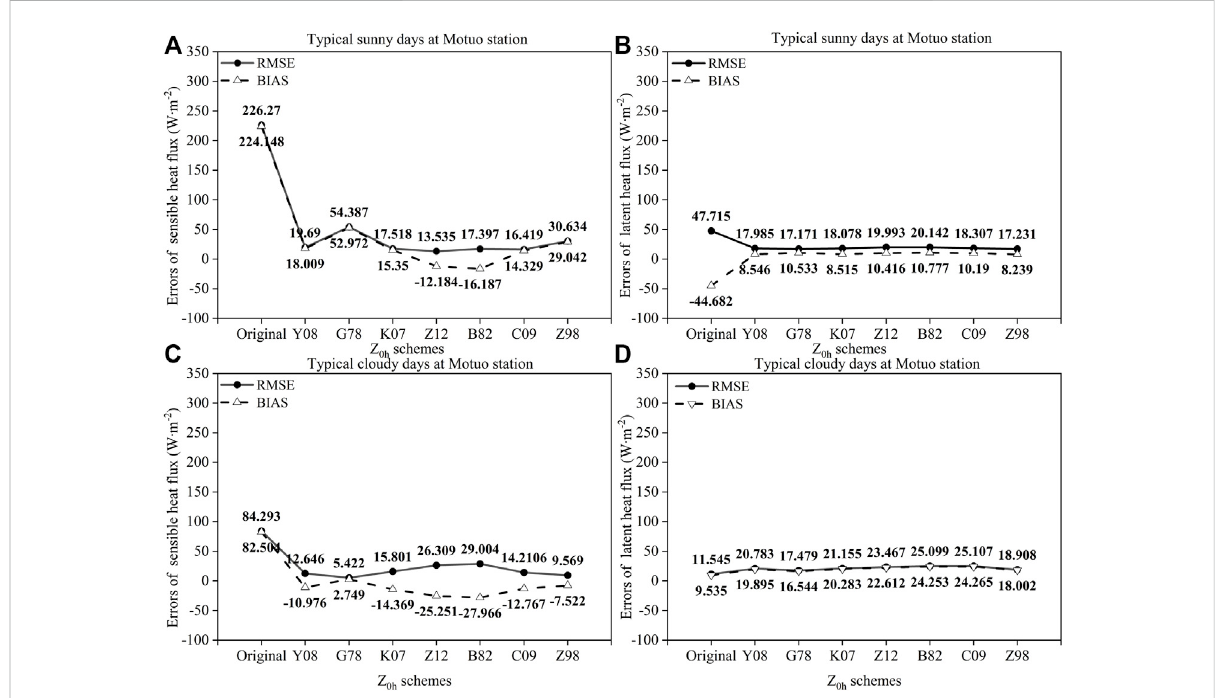
FIGURE 8 Root mean square error (RMSE) and BIAS between simulated and measured values for the period of strong turbulent exchange (12:00 – 16:00) under the typical sunny/cloudy days at Motuo station, (A and C) error in sensible heat fl ux (W · m − 2 ), (B and D) error in latent heat fl ux (W · m − 2